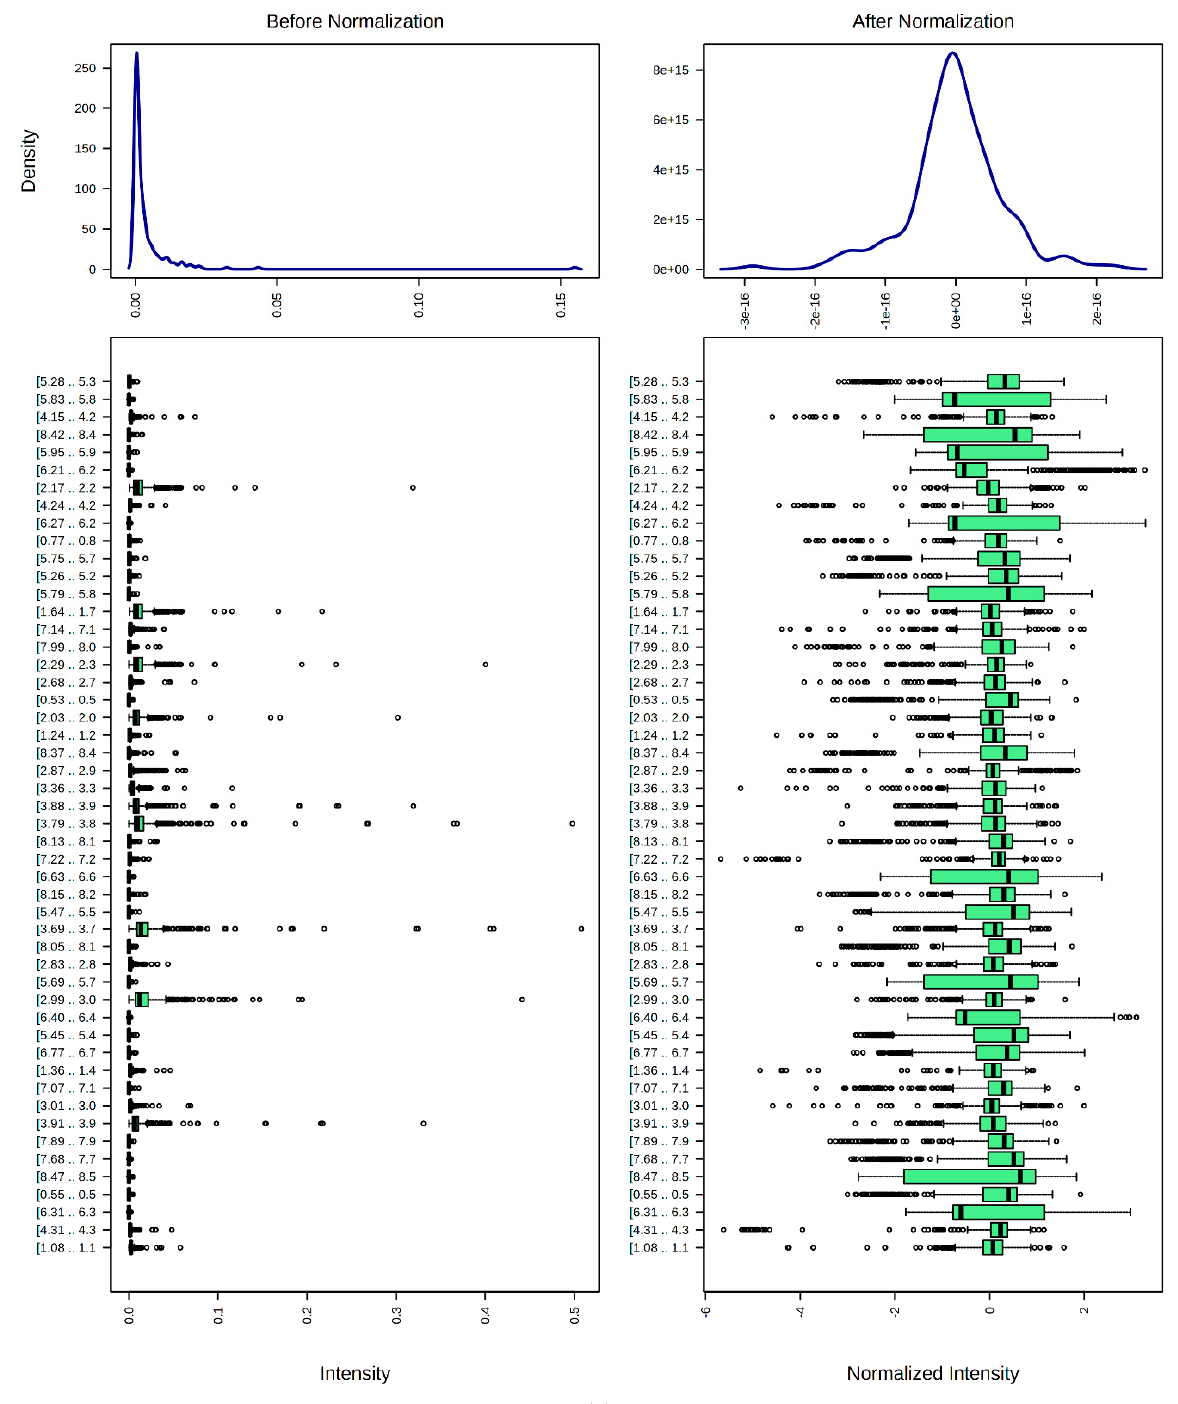
Figure 7. Box and kernel density plots shown for the 50 most important 1 H NMR ISB intensity discriminatory variables before and after row-wise normalization, transformation, and column-wise scaling for the acute sore-throat study dataset. ( a ) With CSN only; ( b ) as ( a ), but also with glog-transformation applied; ( c ) as ( b ), but with Pareto-scaling applied. Prior to statistical analysis, all ISB intensities were normalized to TSP added as an internal standard to WMS supernatant samples analyzed at a final concentration of 238 μ mol./L.